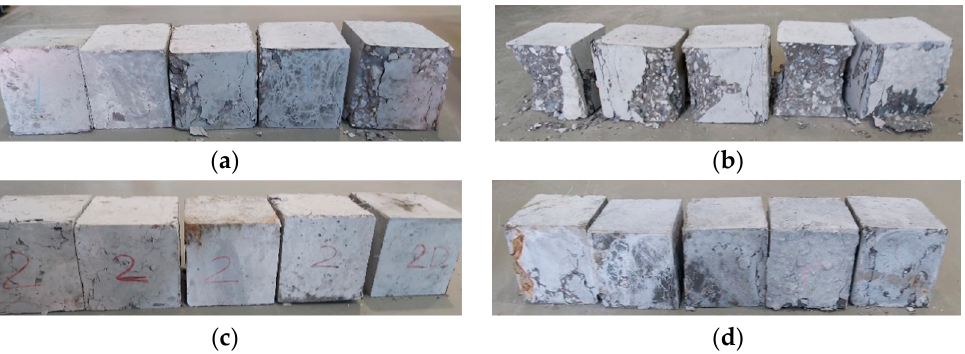
Figure 8. Failure pattern of cube specimens tested in compression: ( a ) NSC-BMF0.0; ( b ) HSC-BMF0.0;